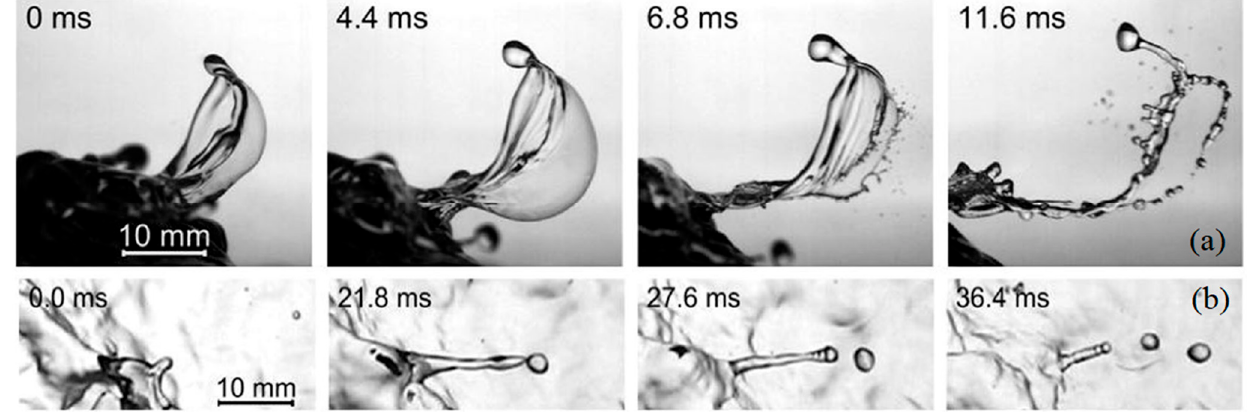
Figure 6. Visualization of entrainment: ( a ) due to bag break-up in the x - z plane; ( b ) ligament break-up in the x - y plane on surface of a 2 m deep gas-sheared liquid layer [44]. For both the thin-film flow [43] and the deep-layer flow [45], it is reported that the liquid bag consists of a thin central film and a thicker rim around it. The central film is